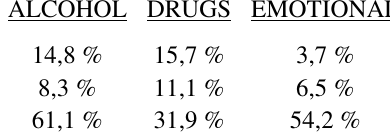
CLASSIFICATION OF TYPICAL PROCEDURES USED IN DEALING WITH PROBLEM CASES (N = 36